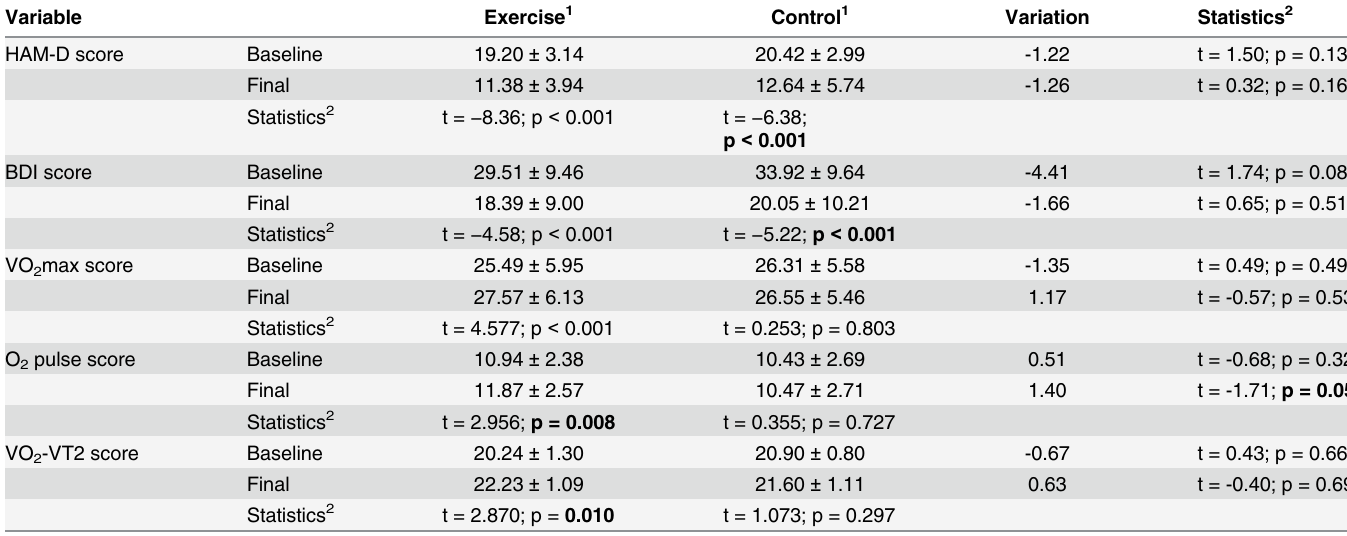
Table 3. Comparison between baseline and final values for the study outcome measures by group.